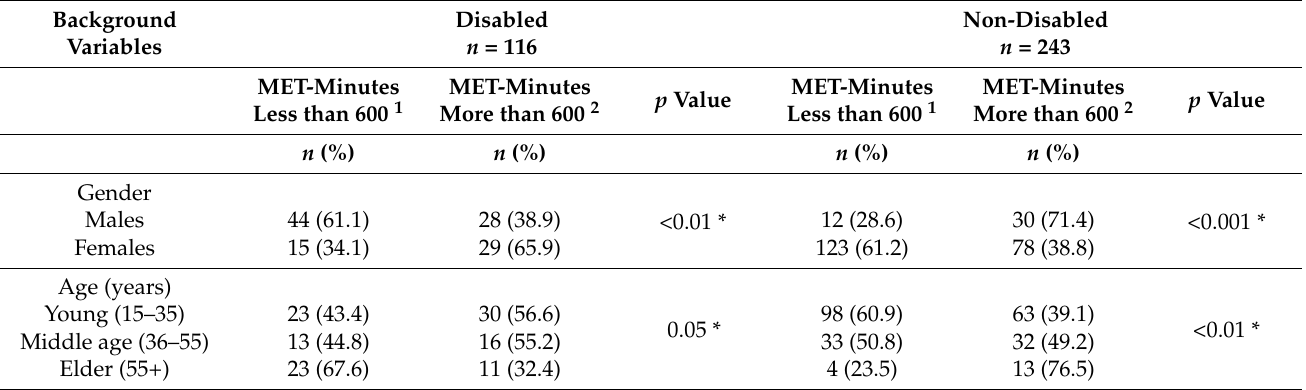
Table 1. Physical activity status of the disabled and non-disabled individuals across gender and age (Chi-square, Bivariate analysis).